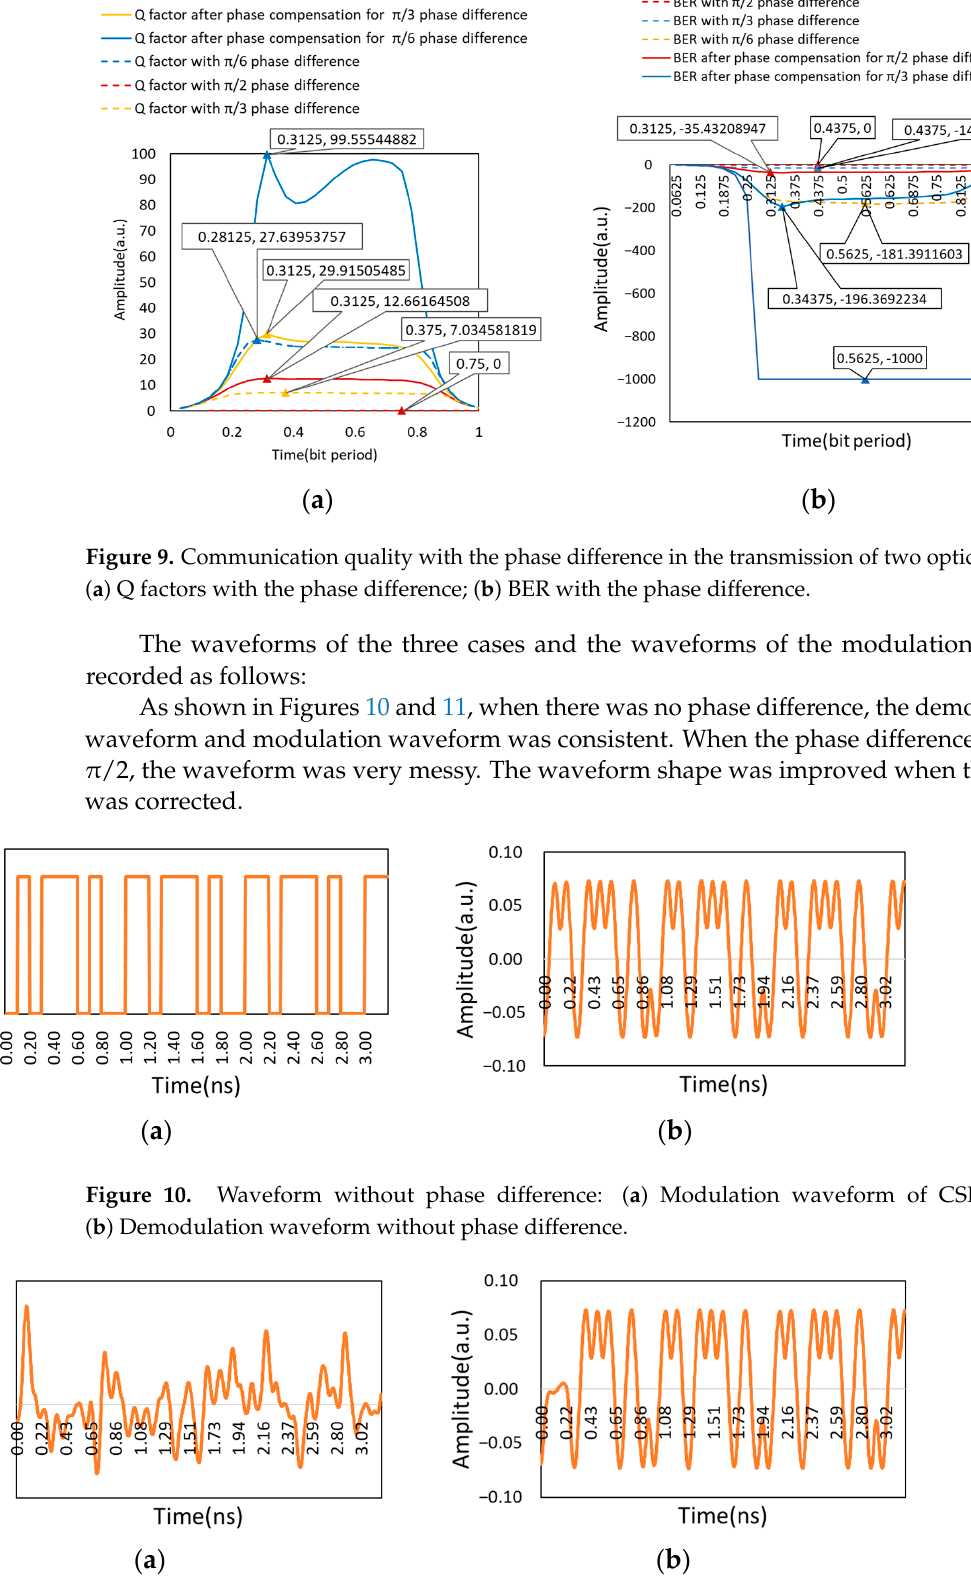
Figure 11. Demodulation waveform: ( a ) Demodulation waveform with π /2 phase difference; ( b ) Demodulation waveform after phase compensation.